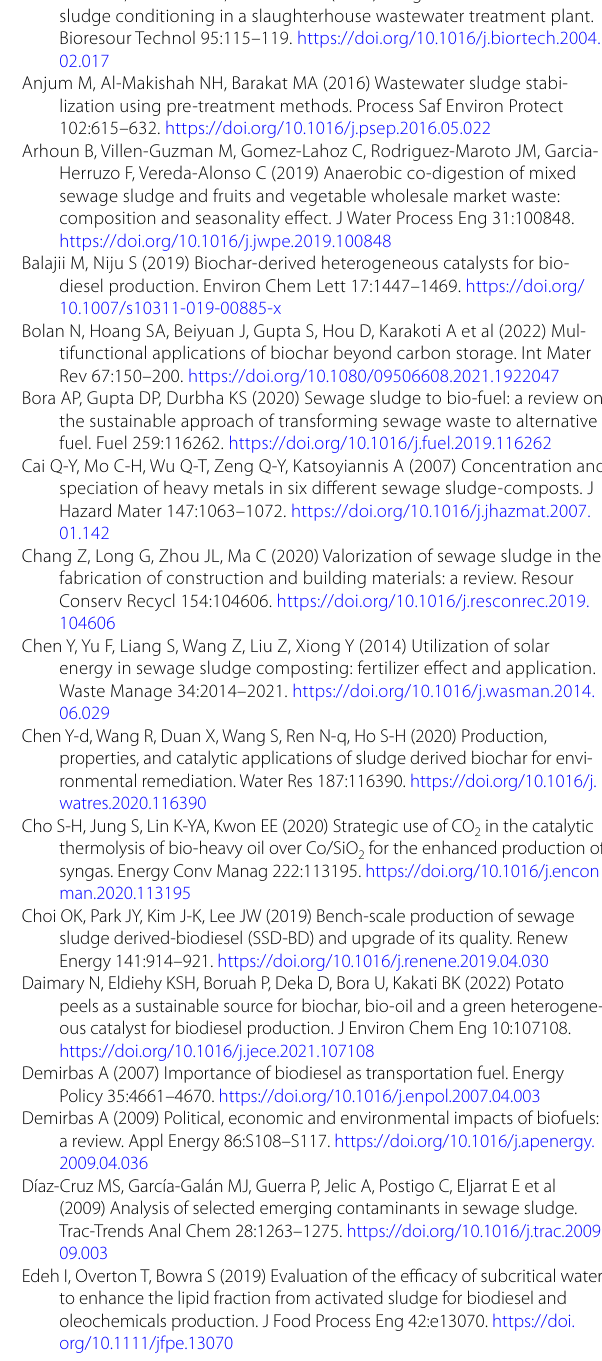
Additional file 1: Fig. S1 . Schematic of the experiment setups used in this study . Table S1. GC/FID operational conditions. Table S2. Concentra‑ tion of FAME for 3‑point RSE. Table S3. Results of 3‑point RSE for QA/QC (Peak area). Table S4. Concentration of FAME for 7‑point MDL. Table S5. Result of 3‑point MDL for